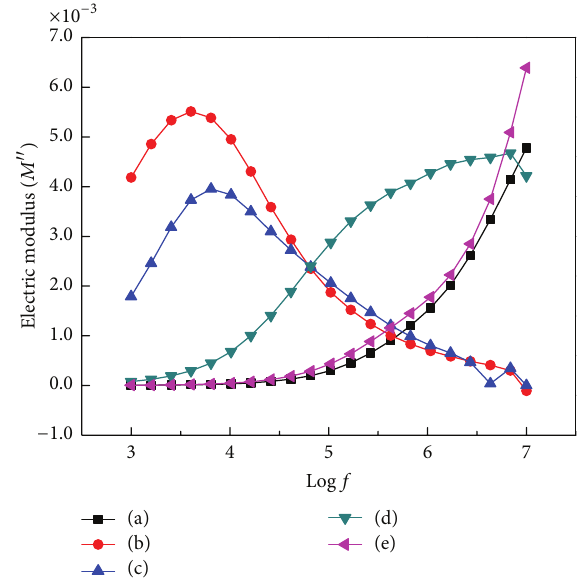
Figure 9: Electric modulus of imaginary part versus log 𝑓 for Ppy/TiO 2 composites: (a) 1 wt% Ppy/TiO 2 , (b) 2 wt% Ppy/TiO 2 , (c) 3 wt% Ppy/TiO 2 , (d) 4 wt% Ppy/TiO 2 , and (e) 5 wt% Ppy/TiO 2